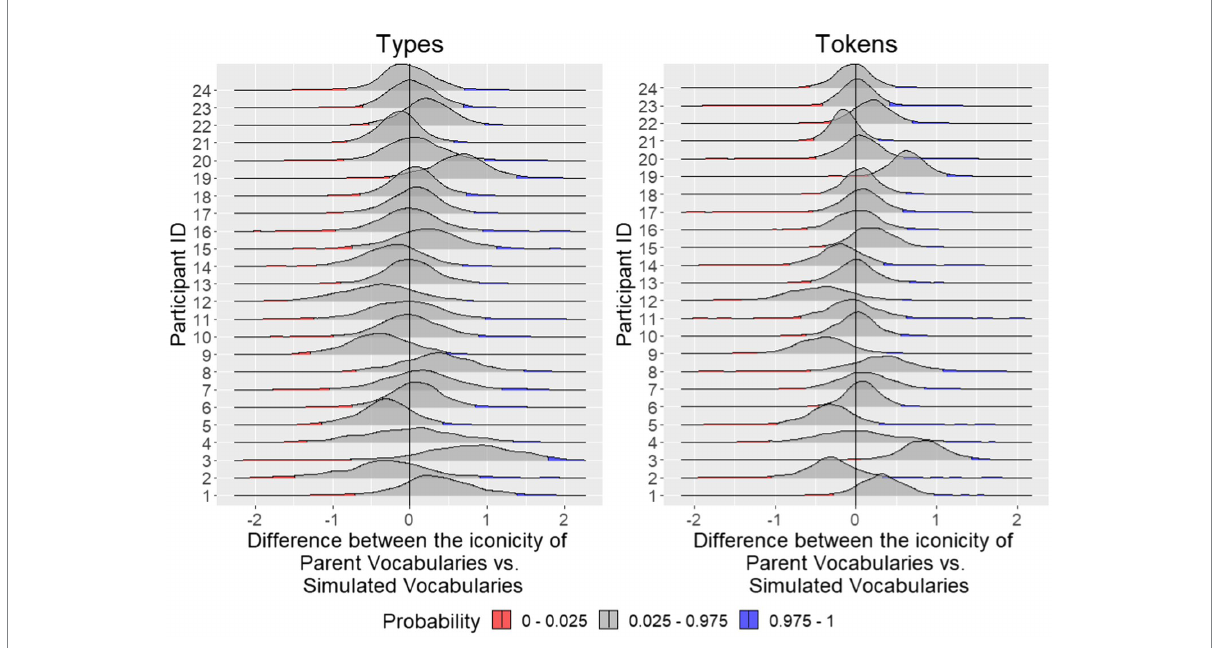
FIGURE 1 The distribution of difference in mean iconicity of 1,000 pairs of Parent Vocabularies and Simulated Vocabularies. The upper and lower bounds of the 95% confidence interval are illustrated in blue and red, respectively. Distributions that largely fall above zero (i.e., the lower bound of the 95% CI is above 0) indicate that parents’ signs were more iconic than chance. In the left panel, iconicity ratings were averaged over sign types, and in the right panel over sign tokens. With the exception of two parents’ tokens (participants 3 and 19), Parent Vocabularies were no more iconic than would be expected by chance.